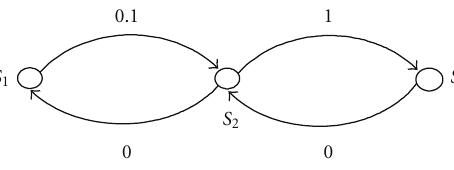
Figure 2: Simplified FSTD with TMTR